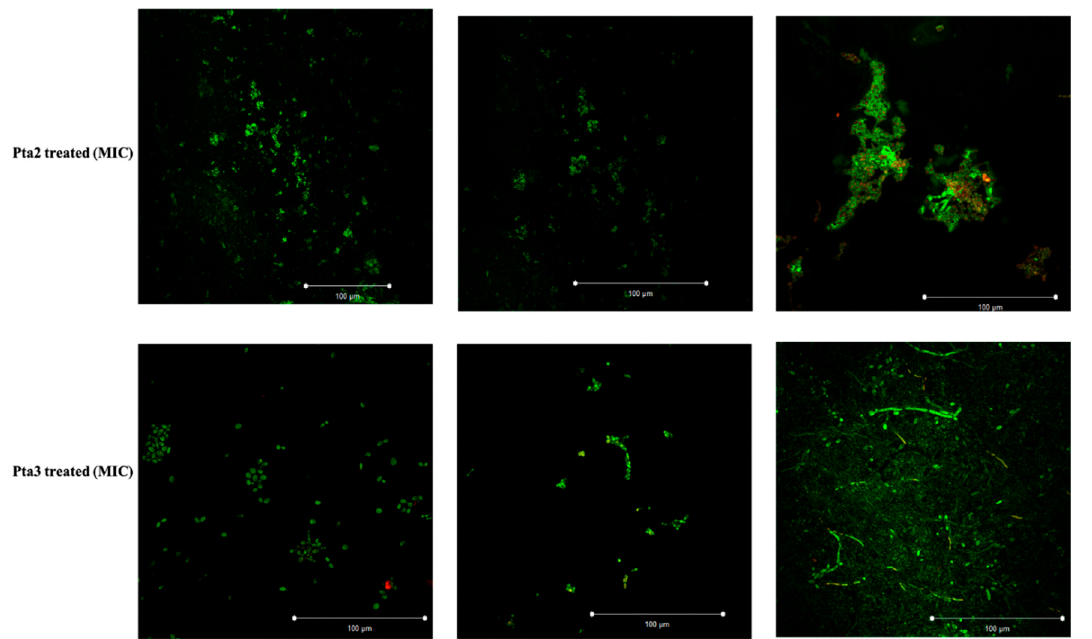
Figure 7. Anti-biofilm activity of piperidine derivatives. Representative figure of different C. albicans biofilms after exposure to pta-1, pta-2, and pta-3 at their inhibitory concentrations. The green fluoresces (Con A) represent the C. albicans cell wall as well as biofilm matrix; yellow-green fluoresces (FUN-1) represent dead/metabolically inactive cells.